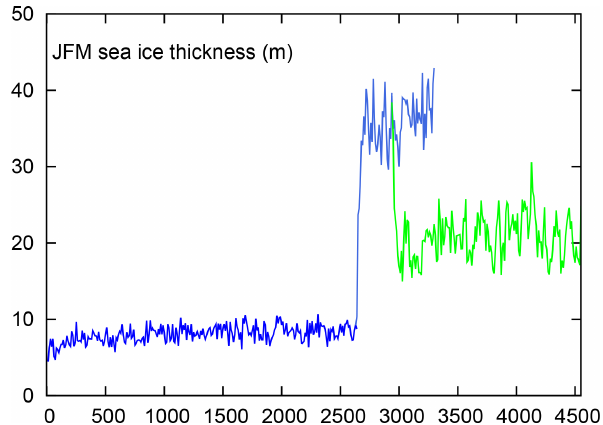
Figure A1. Average sea ice thickness (m) from January to March for the first half of the spin-up of the LGM experiment, averaged over 70–75 ◦ N, 150–180 ◦ E. The blue line: step 1, light blue: step 2, and yellow-green: step 3 in Fig. 5, respectively. For simplicity, data for 1 year for every 10 years are